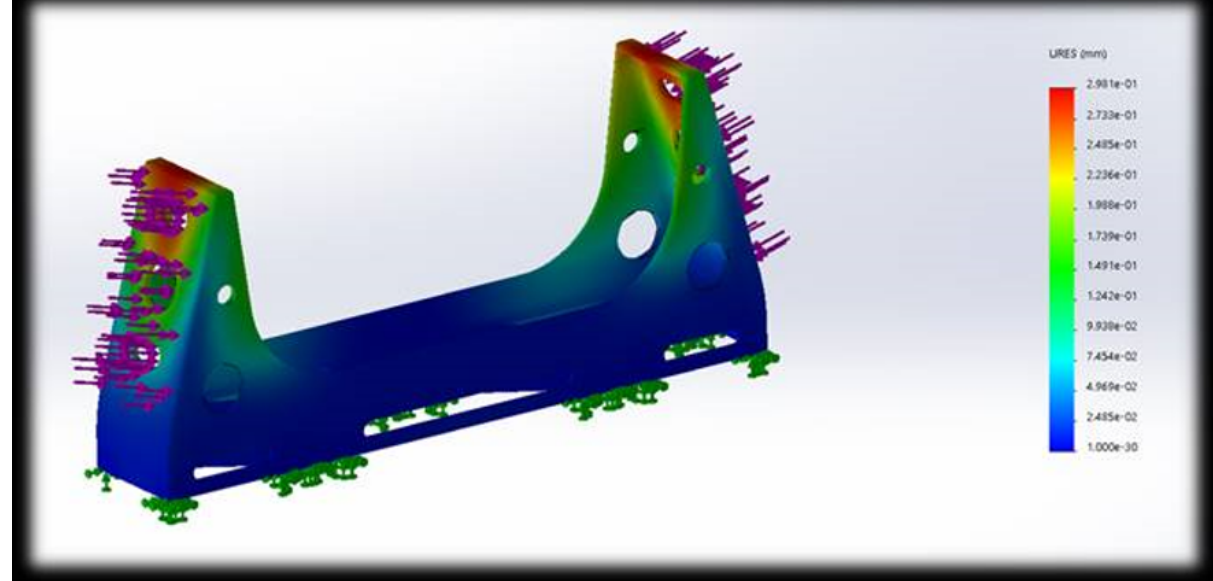
Figure 6: Deformation simulation of front axle